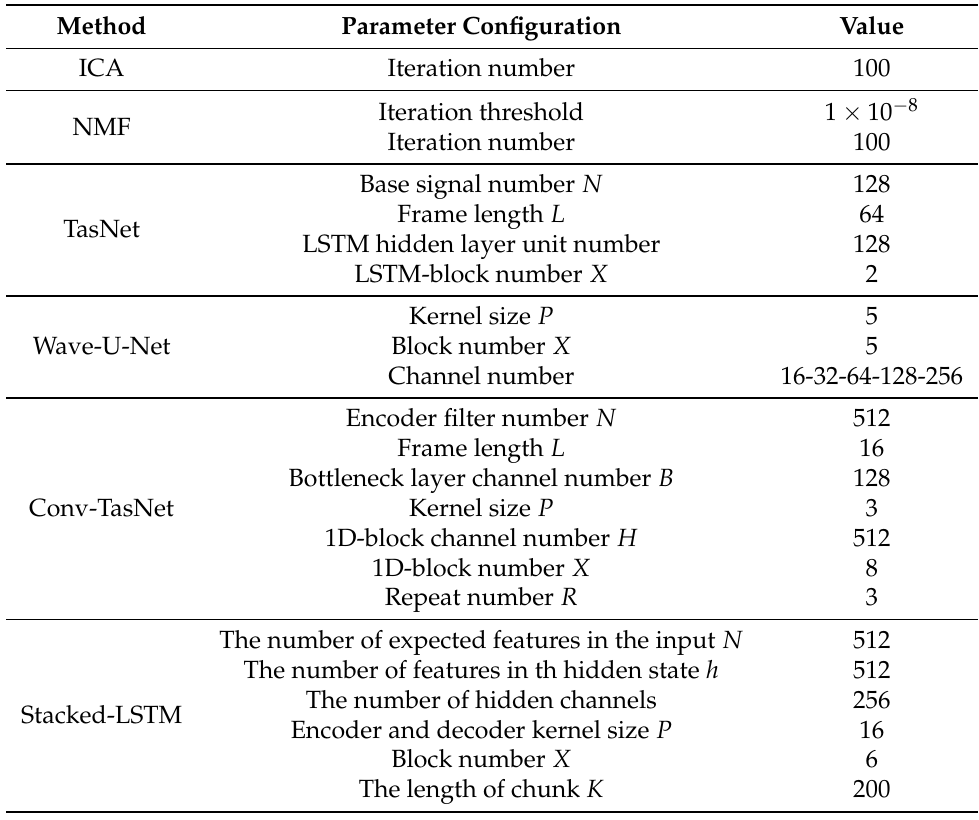
Table 2. Parameter configuration of five